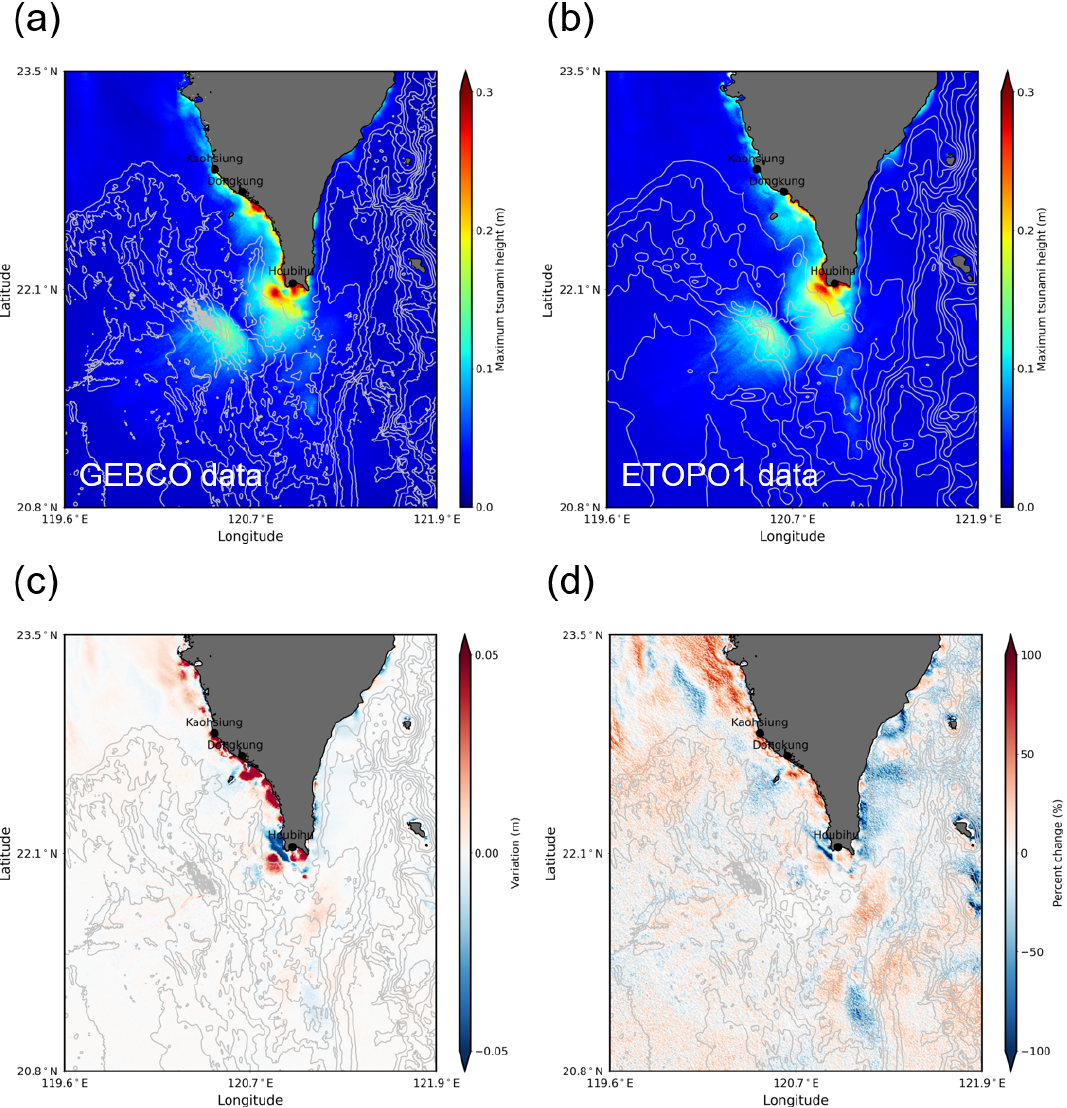
Figure 19. Simulated maximum tsunami height using open-source bathymetry data: (a) GEBCO and (b) ETOPO1 data. (c) The variation and (d) the percent variation in the simulated maximum tsunami height using two sources of bathymetry data. The black circles indicate the locations of the tide gauge stations. The bathymetry contour is 500m based on the GEBCO or ETOPO1 bathymetric